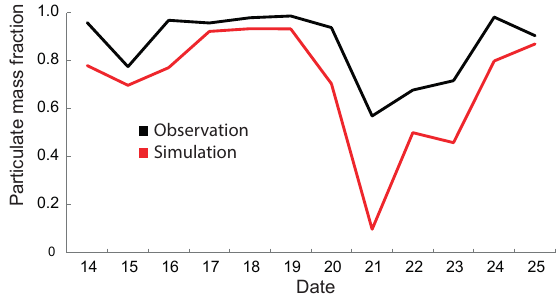
Figure 6. Simulated and observed daily averaged particulate mass fraction of CHR at the Gosan site during 14–25 February